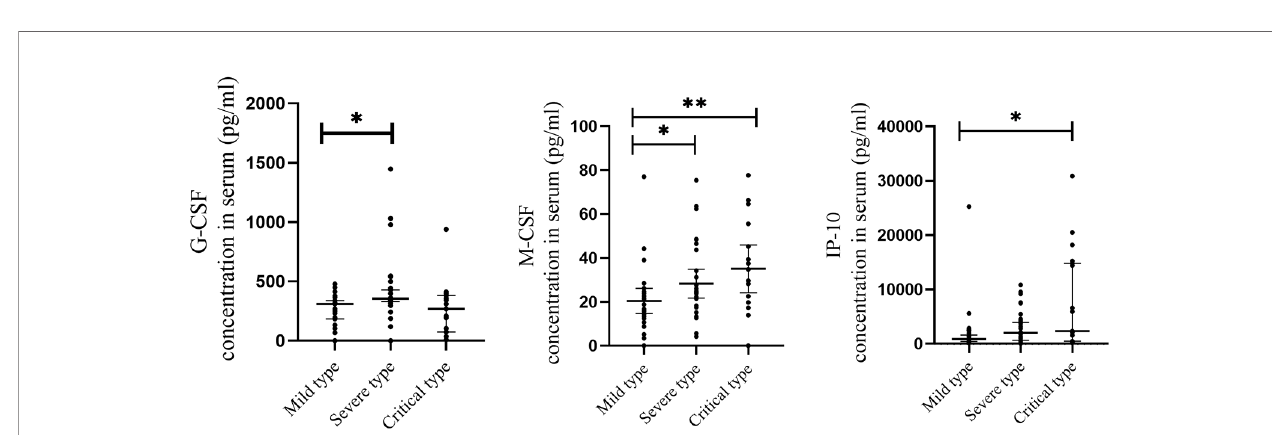
FIGURE 3 | Comparison of serum cytokine concentrations between COVID-19 patients with different severity of illness. Serum samples from critically ill (N=17), severe (N=30), and mild (N=28) COVID-19 patients were collected at the earliest possible time point after hospitalization for assays measuring the concentrations of 48 cytokines. 2 cytokines with signi fi cantly increase in severe cases when compared with mild type, including G-CSF and M-CSF. 2 cytokines with signi fi cantly increase in critical cases when compared with mild type, including IP-10 and M-CSF. *P < .05, **P <